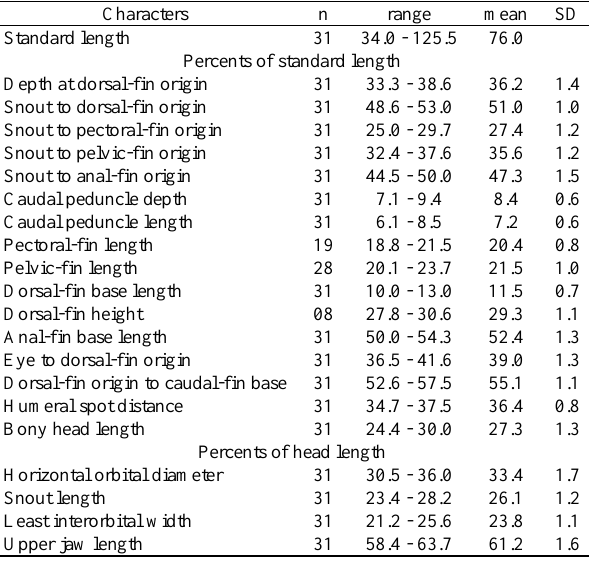
Table 5 . Morphometrics of Charax gibbosus . Specimens are from MZUSP 5164, 10674, 10675, 10679, 38226,